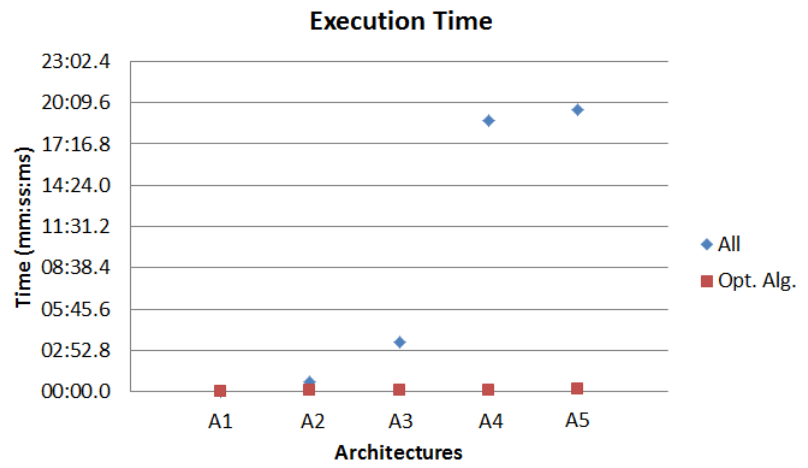
Figure 15. Execution